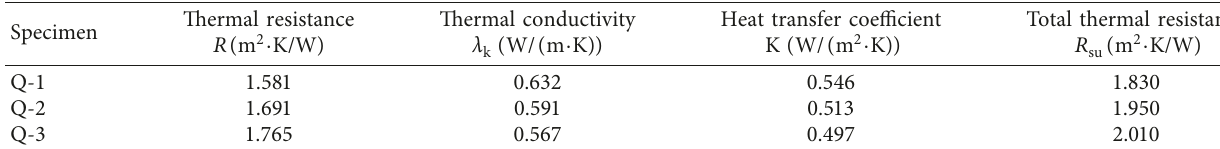
Figure 12: Simplified heat transfer model of the block wall. Table 6: Thermal parameters of test specimens.